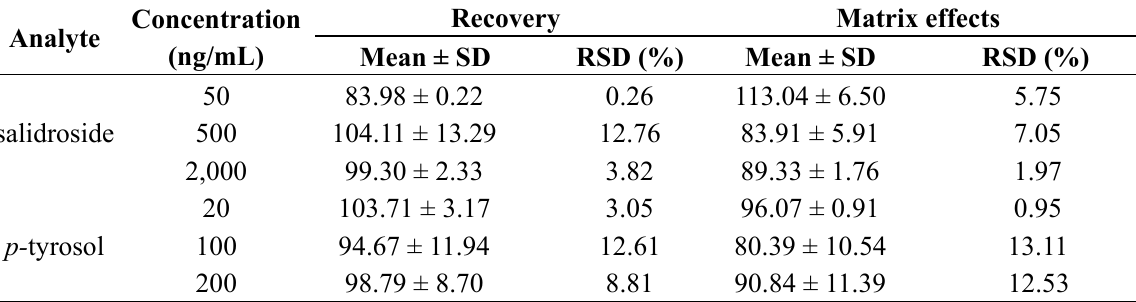
Table 3. Recovery and matrix effects of salidroside and p- tyrosol in plasma samples (n = 3).